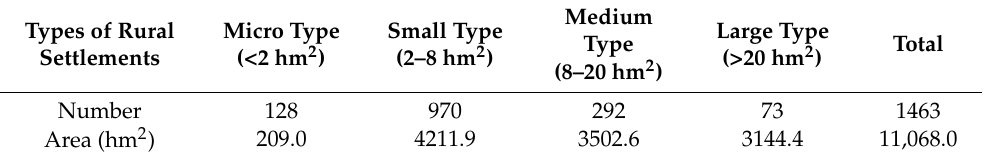
Table 2. Statistics of rural settlements of different sizes in the Lijiang River